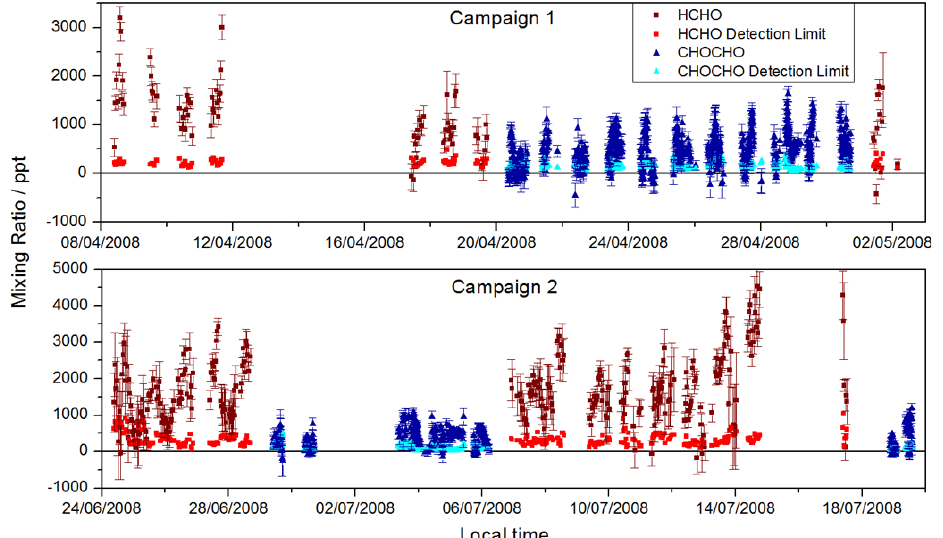
Fig. 5. Time series for formaldehyde and glyoxal over both campaigns. The red squares show the measured formaldehyde and the associated detection limit and the blue triangles are those for